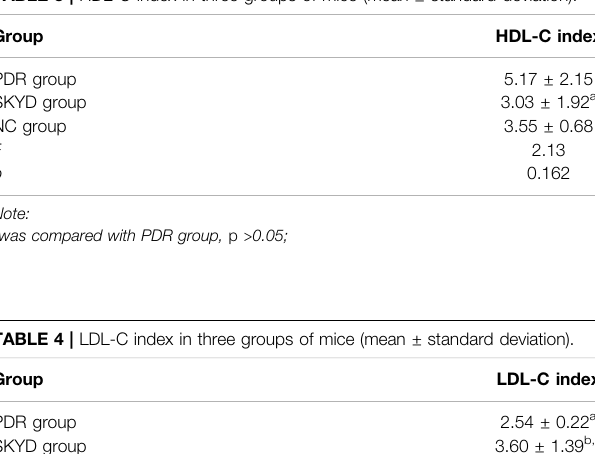
TABLE 3 | HDL-C index in three groups of mice (mean ± standard deviation).